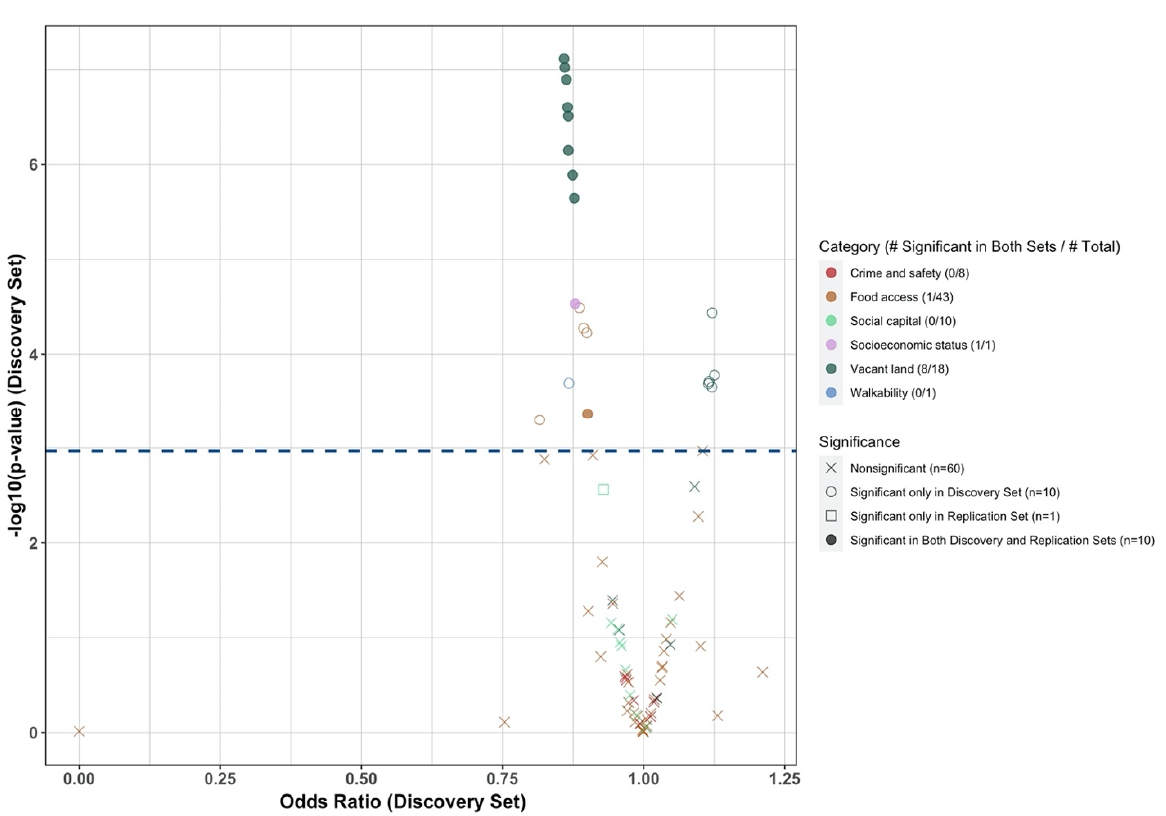
Table 3. Significant social determinants of health variables associated with the use newer antidia- betic drugs identified by the two-phase approach.